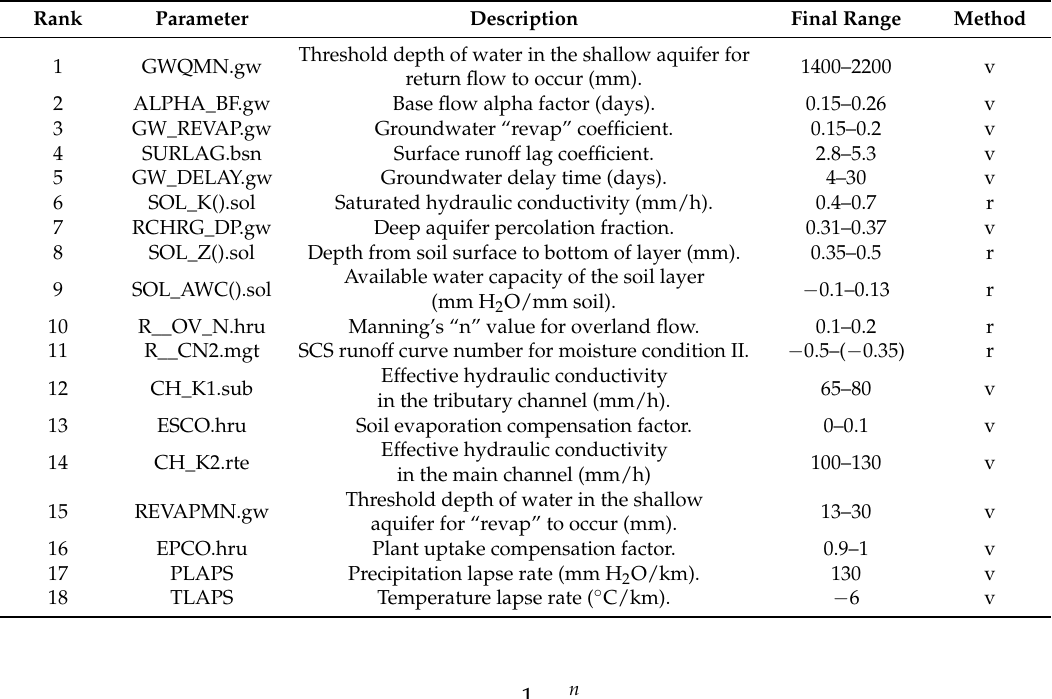
Table 4. Ranking of the calibrated parameters, according to their sensitivity and significance. A “v” in Method implies a replacement of the initial parameter value with the given value in the final range, whereas an “r” indicates a relative change to the initial parameter